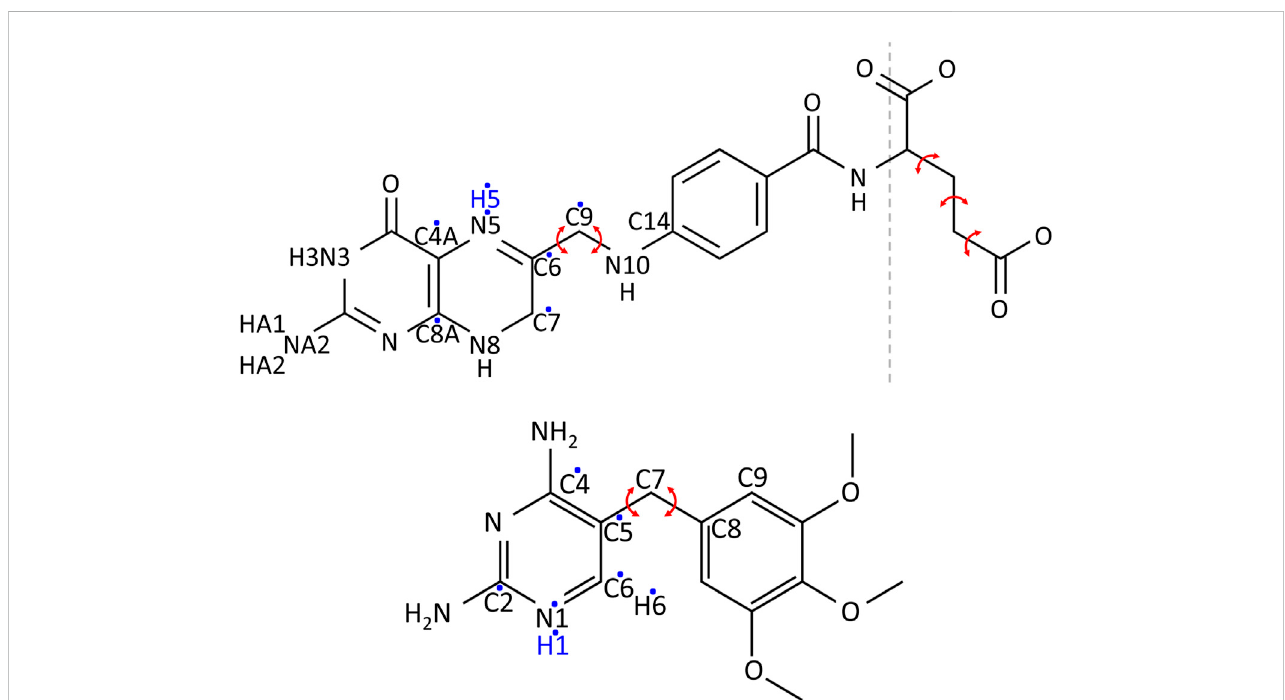
FIGURE 1 Chemical structures of DHF (above) and TMP (below). Red arrows indicate the bond rotations de fi ning ligand conformers. A dashed line separates DHF intothefragmentusedinGaussiancalculations(left)andtheglutamicacidfragment(right).Hydrogensaddedintheprotonatedformoftheligandsareinblue. Dots indicate the atoms among which the extra charge is distributed upon